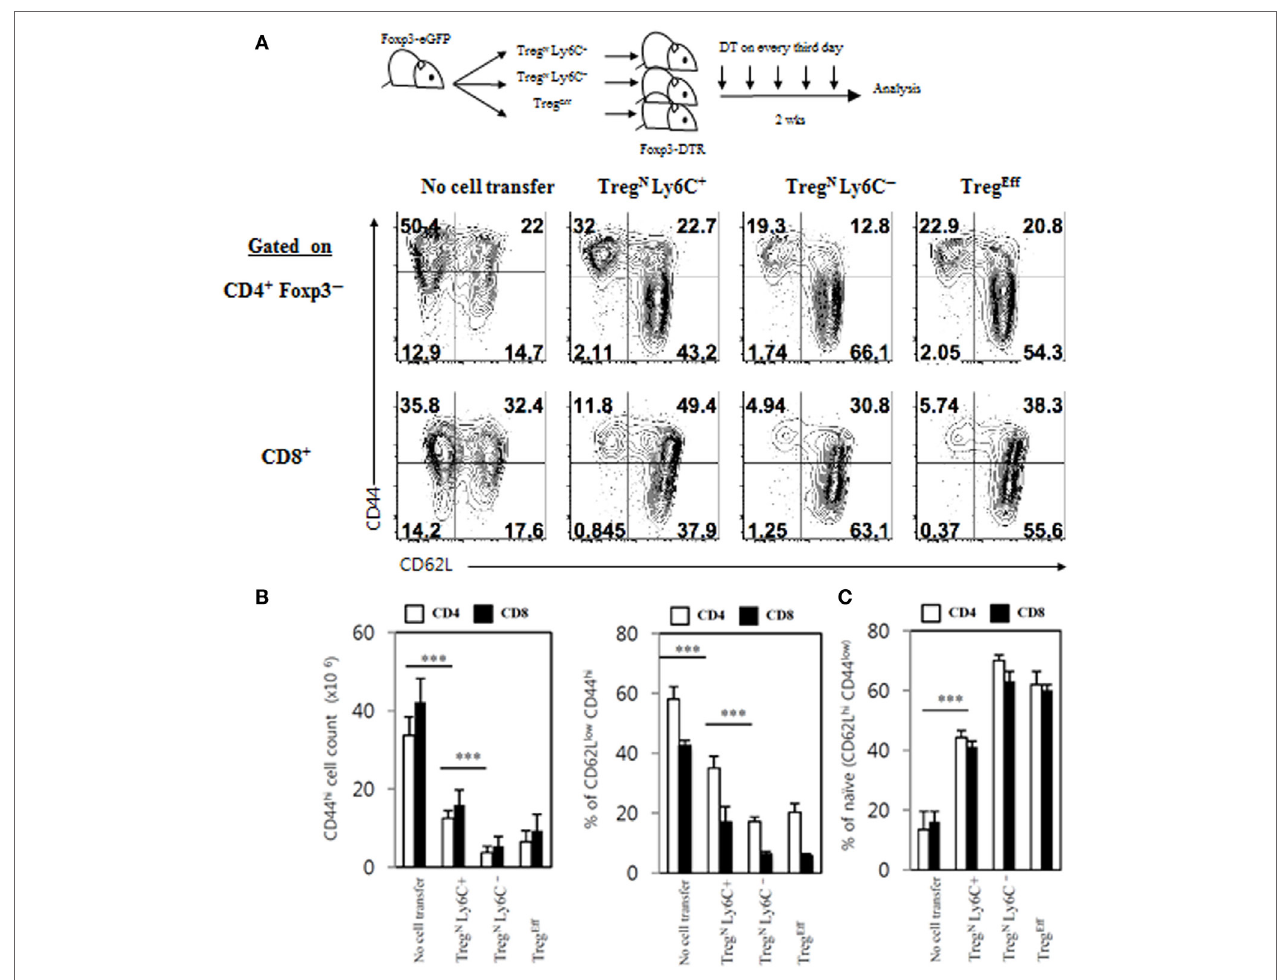
FigUre 8 | Restoration of immune-suppressive activity of Treg N Ly6C + cells. (a) T regulatory (Treg) subsets from Thy1.1 + Foxp3-eGFP mice were labeled with cell tracker violet and then injected into wild-type or Foxp3-DTR hosts. The hosts were treated with 1 µg of diphtheria toxin in every third day until day 14. Shown are FACS plots for CD44 and CD62L expressions on host CD4 and CD8 T cells in PLN on day 14 after transfer of Treg subsets. Absolute cell numbers (B) and frequencies (B,c) for the gated subsets indicated were calculated based on the data shown in (a) . The data are representative of three experiments comprising three to five mice per group. * p < 0.05, ** p < 0.01, and *** p <